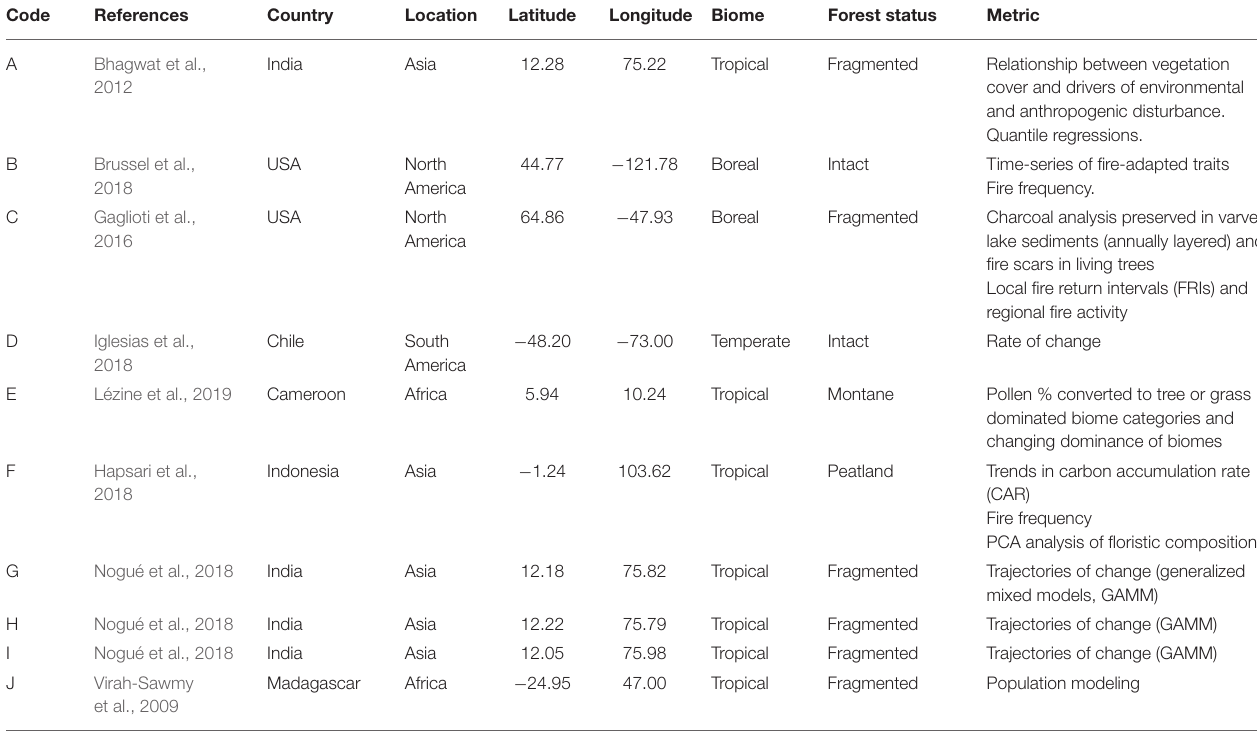
TABLE 1 | List of paleoecological studies from intact forests featured in Figure 1